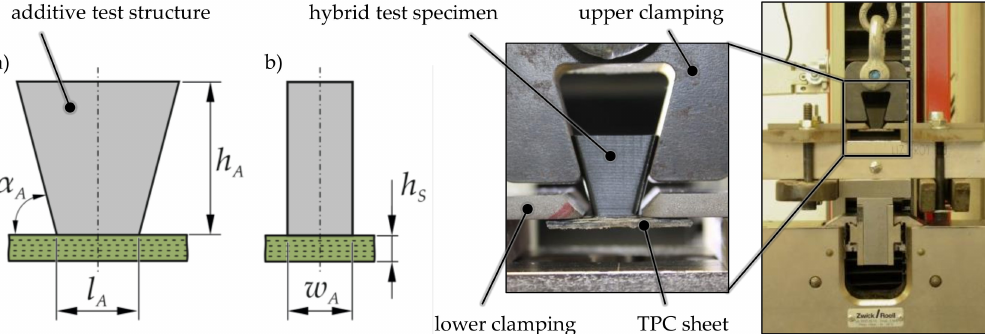
Figure 4. Adapted sample geometry: ( a ) front view (h A = 17.5 mm; l A = 10 mm; α A = 75 ◦ ); ( b ) side view (h S = 2 mm; w A = 10 mm) and test setup.